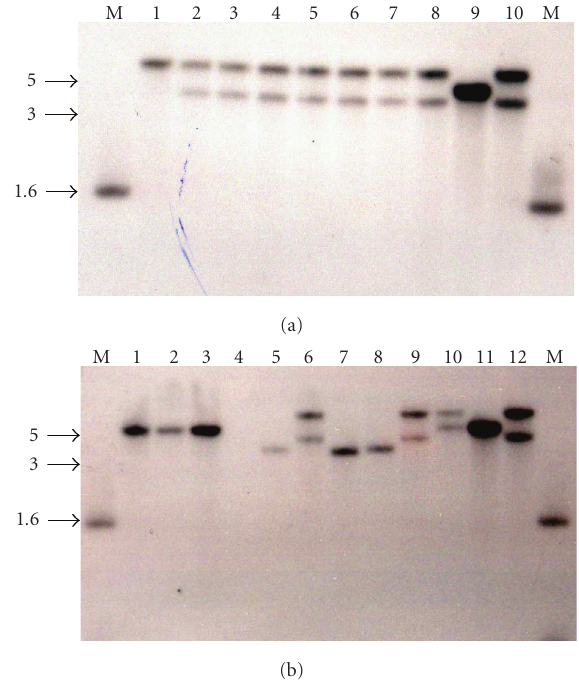
Figure 2: Southern analysis of chromosomal DNA from Staphylo- coccus species hybridized with a probe specific for hysA . Panel (a) S. aureus NCH 247 (1), NCH 248 (2), NCH 249 (3), NCH 250 (4), NCH 251 (5), NCH 252 (6), NCH 253 (7), NCH 254 (8), NCH 78 (9), and NCH 88 (10). Panel (b) S. aureus NCH 310 (1), NCH 338 (2), NCH 340 (3), S. epidermidis ATCC 14990 T (4), S. aureus NTH 68 (5), NTH 69 (6), NTH 70 (7), NTH 71 (8), NTH 72 (9), NTH 73 (10), NCH 78 (11), and NCH 88 (12). M: marker